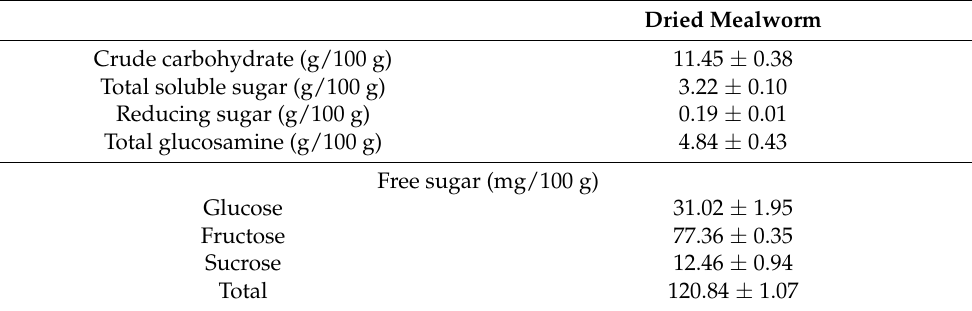
Table 1. Carbohydrate content and its composition in dried